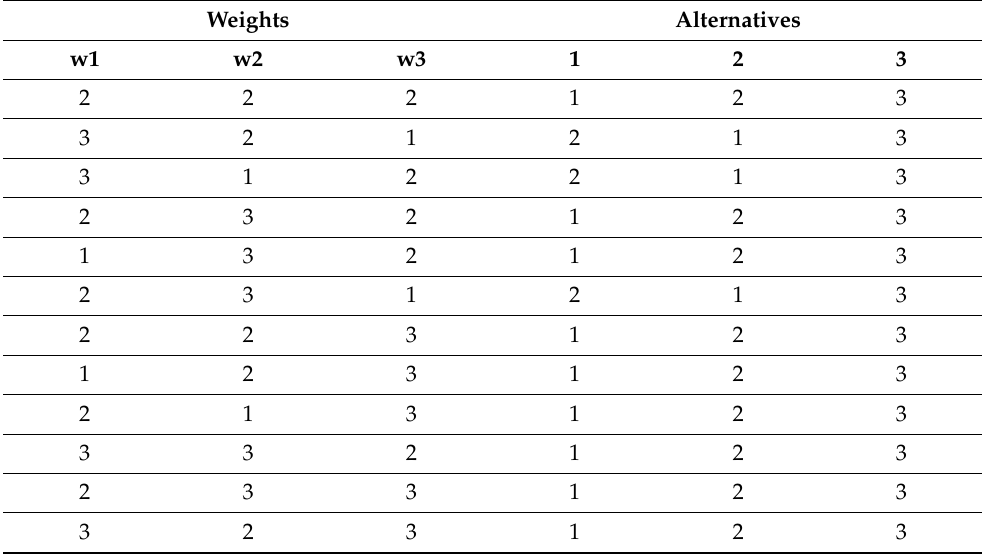
Table 10. Preferability rankings of the design alternatives taking into account the possible ordinal systems of weighting of the